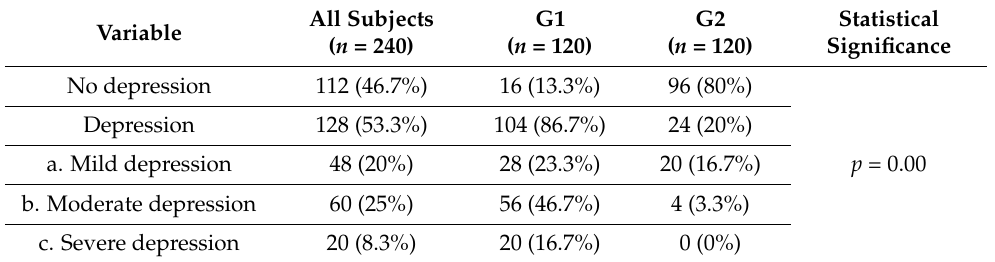
Table 3. Analysis of depression occurrences and its severity in the studied group.